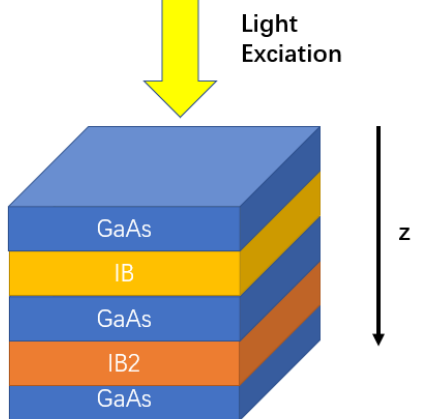
Figure 1. Simple structure of dual-intermediate-band solar cell.